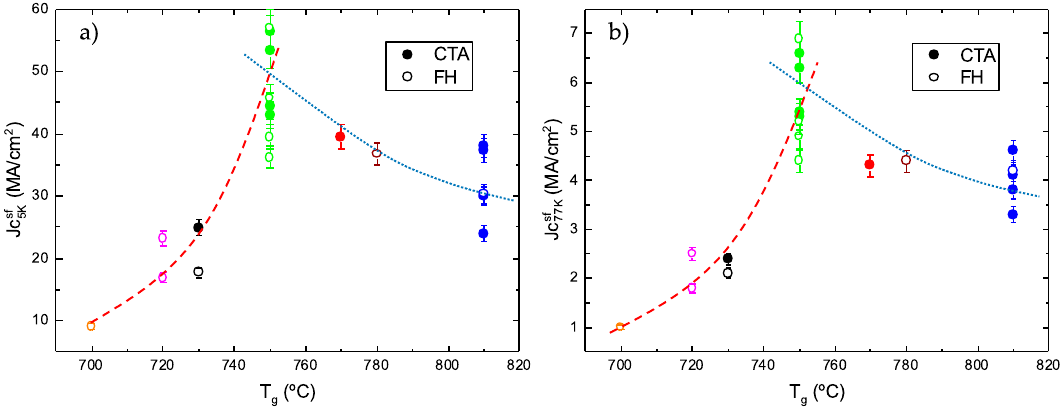
Figure 6. Self-field J c as a function of the growth temperature for samples grown by CTA (closed symbols) and FH (open symbols) at ( a ) 5 K and ( b ) 77 K. The wider scattering of data points at 750 °C and 810 °C comes from the fact that a large number of samples were tested at those temperatures. Dashed and dotted lines are provided as a guide.